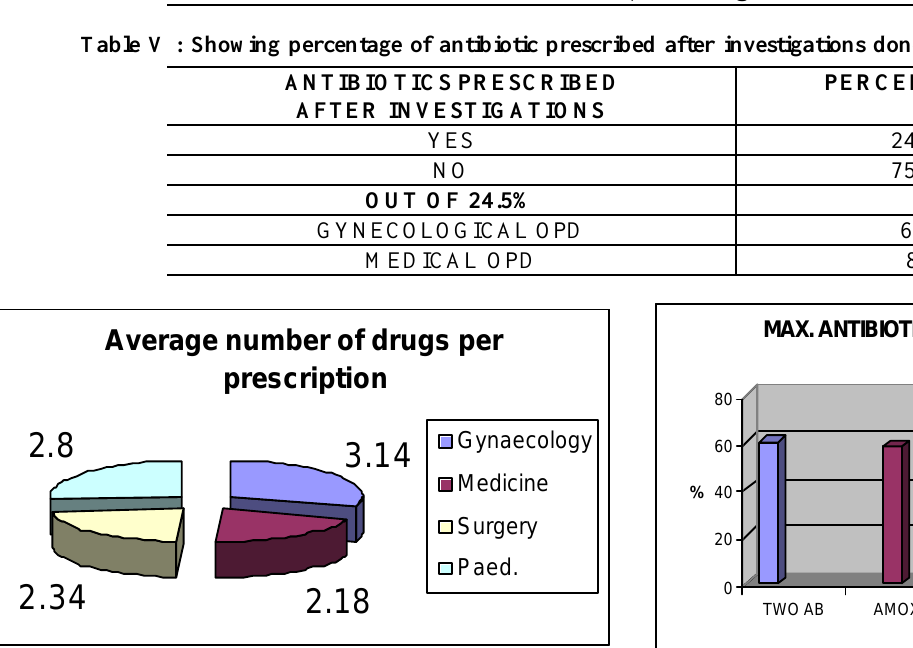
Fig. 3 : Showing commonest health problems & commonest